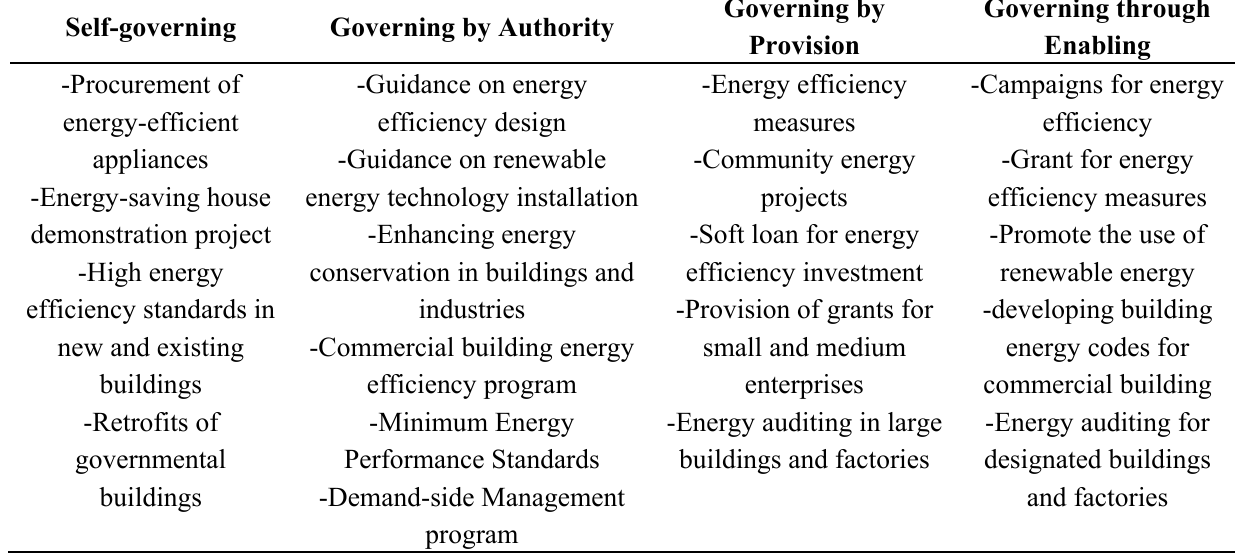
Table 4. Modes of governance and energy policies in